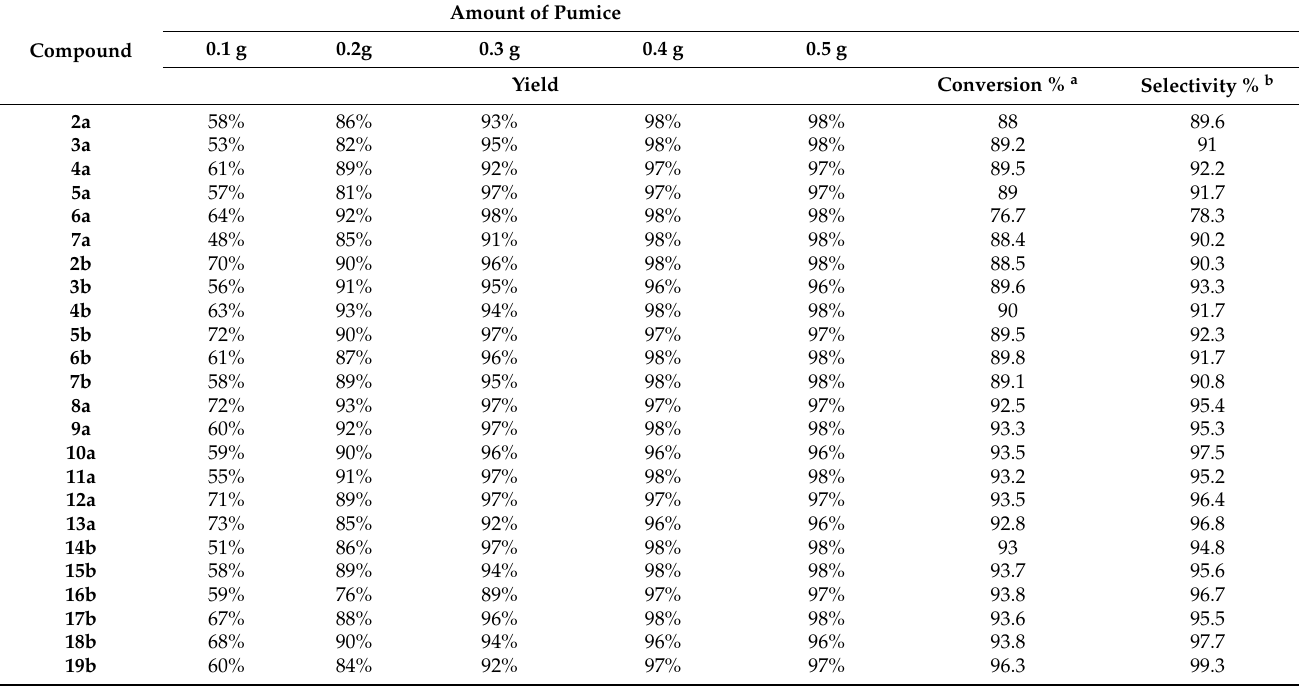
Table 1. Comparison amounts of pumice and yields, conversion, and selectivity % for Biginelli reactions under free solvent conditions.